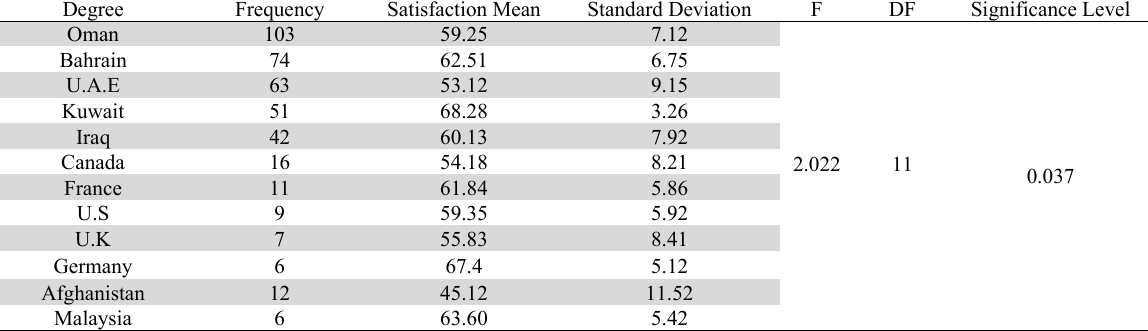
Difference of Satisfaction Degree among Foreign Medical Tourists